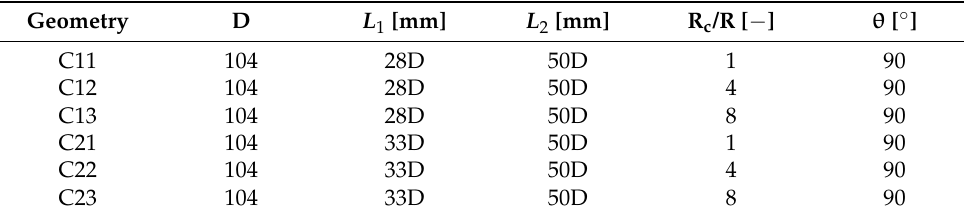
Table 4. Geometric dimensions in the study cases.